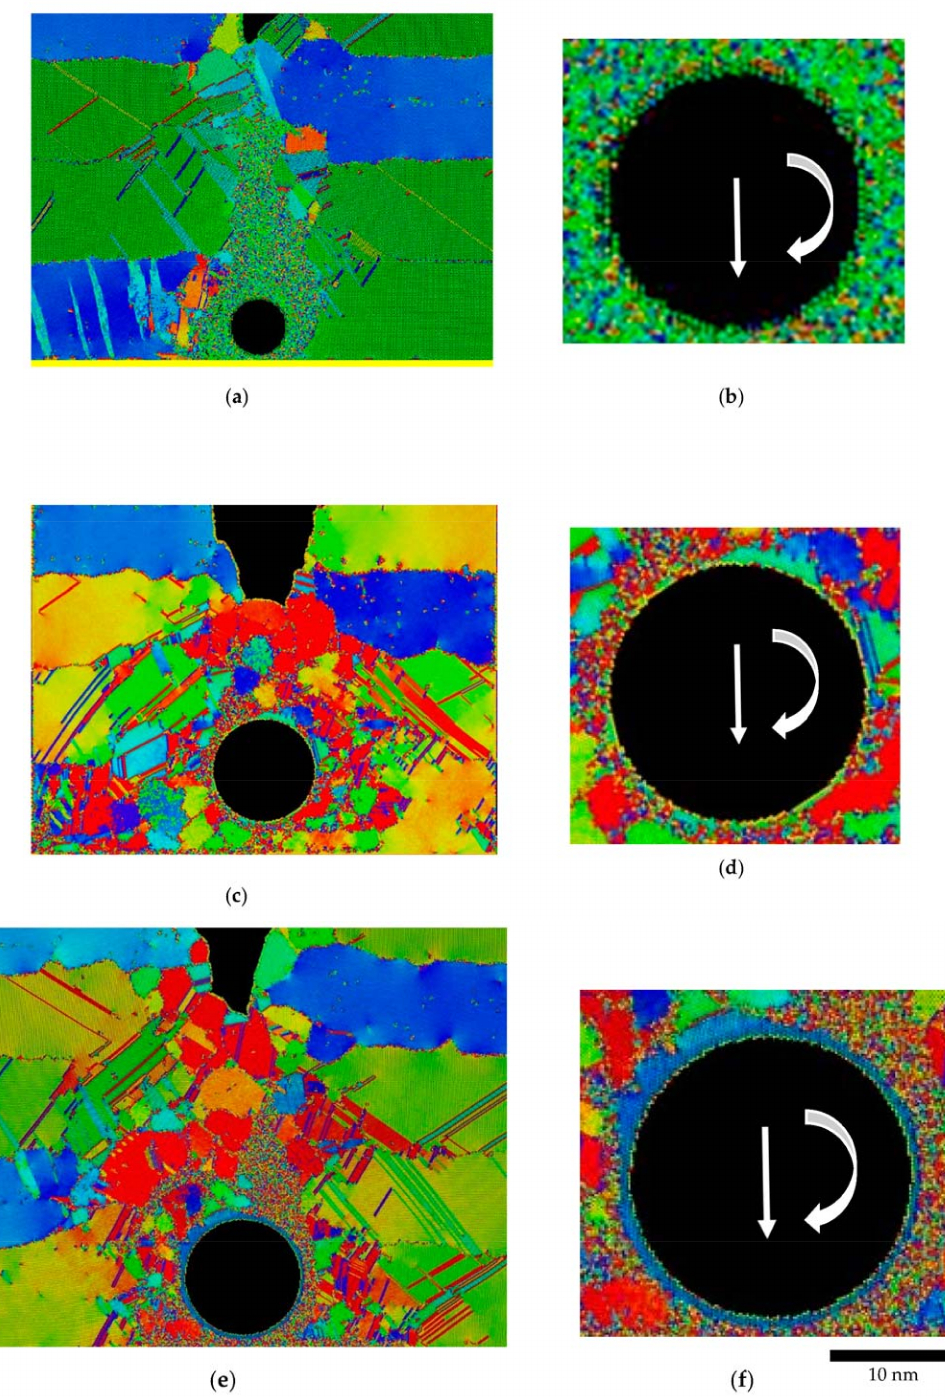
Figure 3. Atomic configurations after welding positions at 0.01 (ps − 1 )/100 (m/s): ( a , b ) 27 k atoms, ( c , d ) 678 k atoms, and ( e , f ) 1.27 M atoms. The colors indicate the crystallographic orientation of the atom clusters except for black, which represents air/pin. White arrows indicate the advancing and rotating